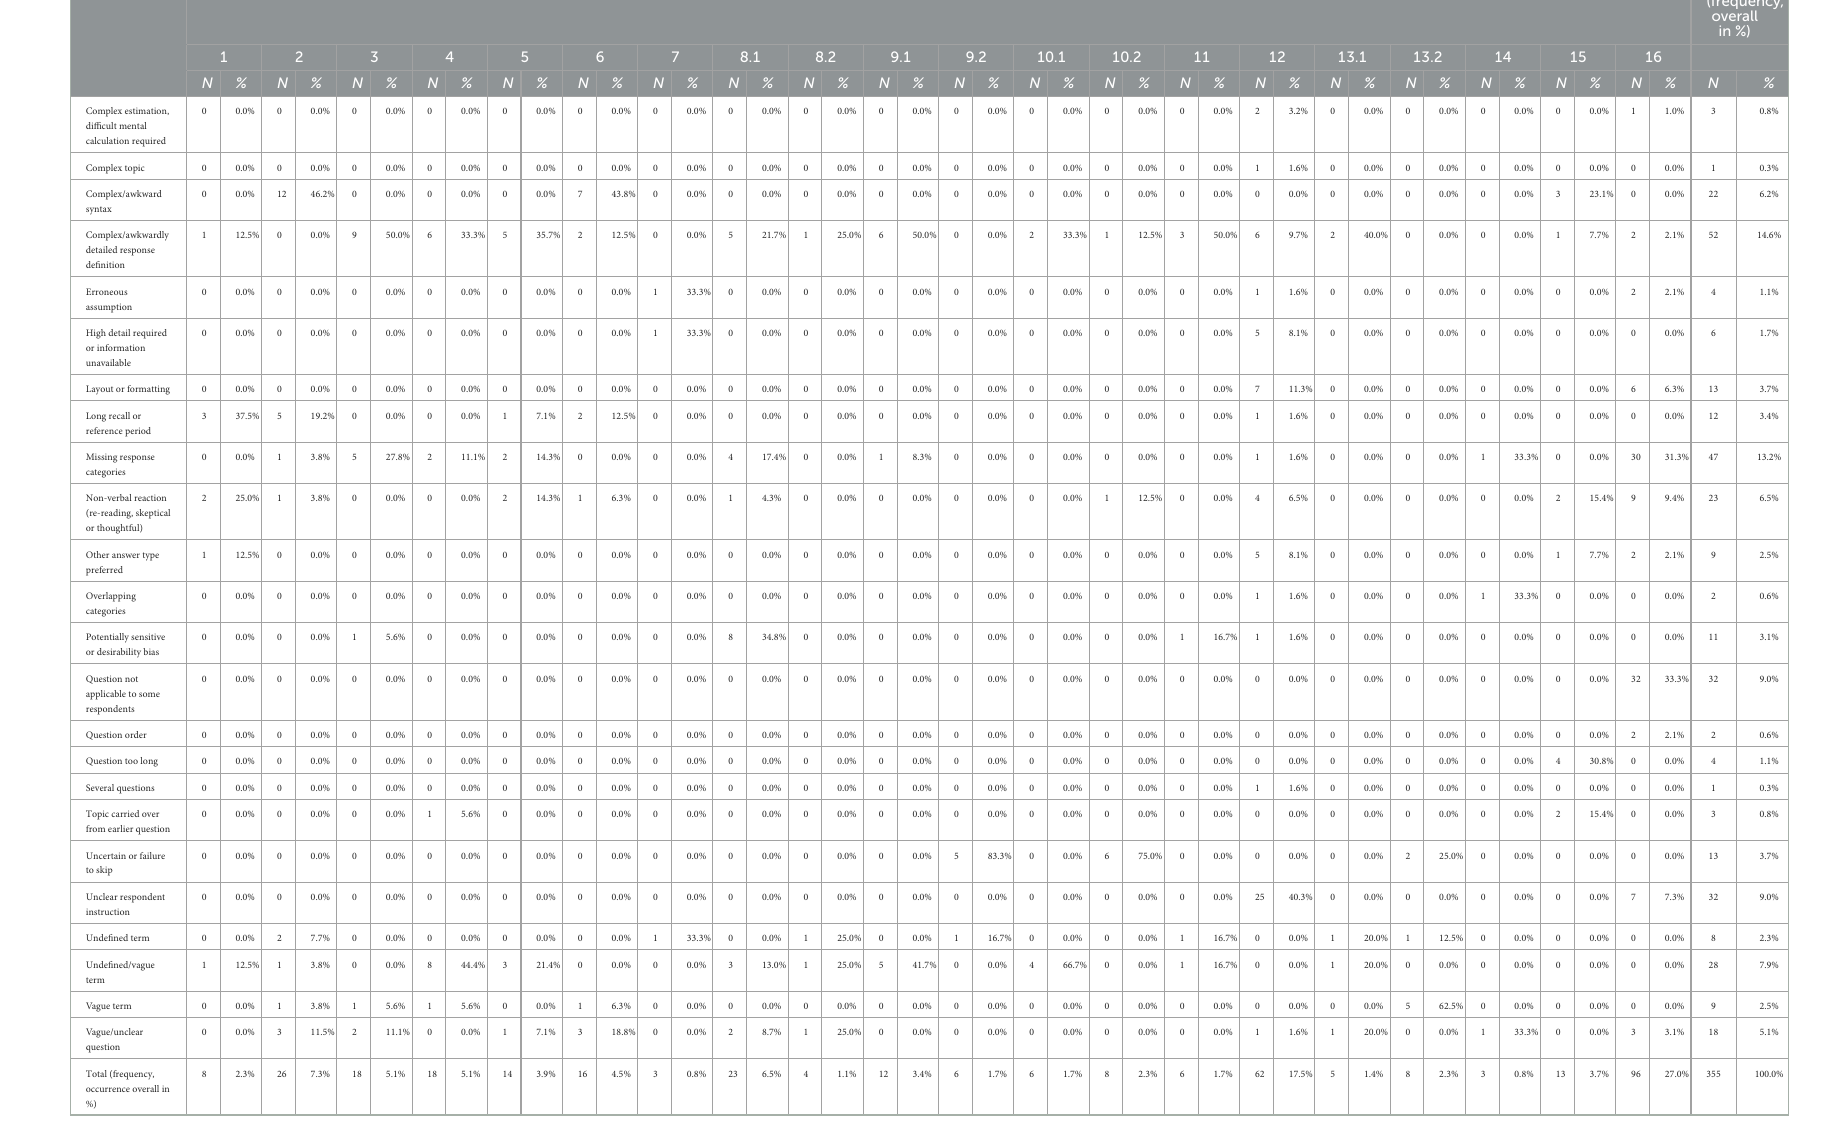
TABLE 4 Problem labels for the classification coding scheme codes of each question of the pGDQ compiled by the interview protocols of patients with Parkinson’s disease and healthy controls for the phase 2a